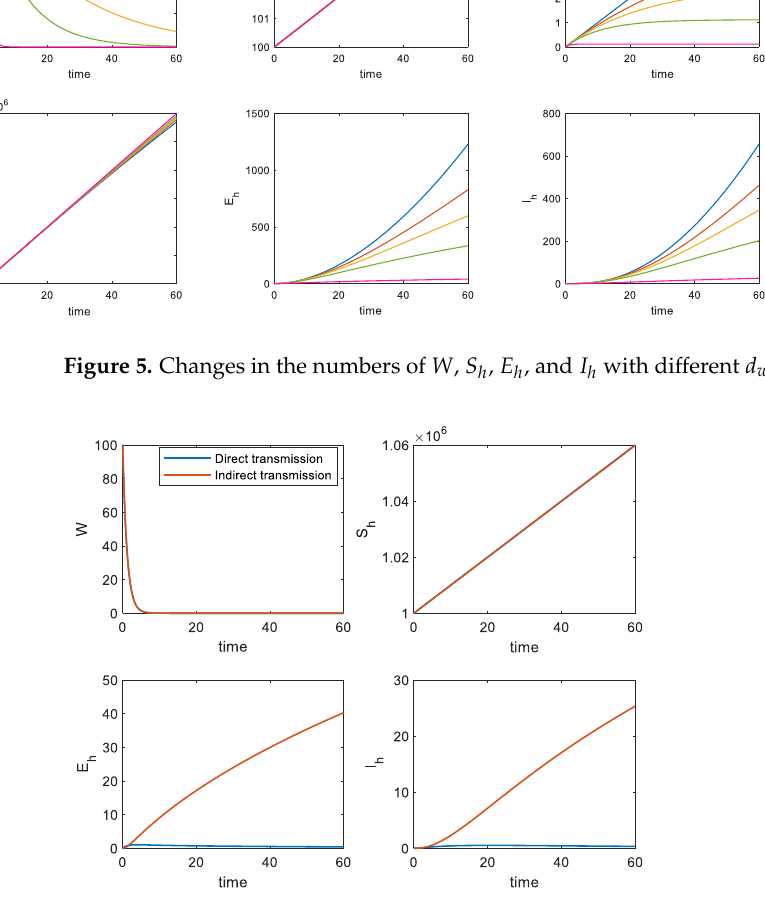
Figure 6. Changes in the numbers of W , S h , E h , and I h with d w = 0.85 in model 1 (direct transmission) and 2 (indirect transmission).